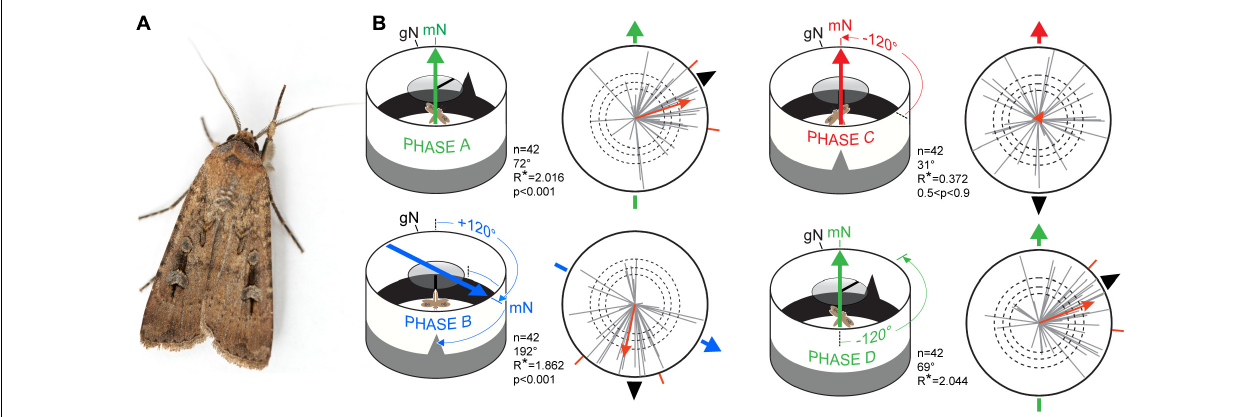
FIGURE 6 | Migratory orientation in Bogong moths is multimodal. (A) A male Bogong moth ( Agrotis infusa ). (B) Experimental procedure and results. Each tethered moth was subjected to magnetic and visual cues during four 5-min phases (termed phases A–D) and their directions and directedness (orientation and length, respectively, of gray vectors in circular plots) measured. When the positions of the magnetic field ( heavy colored arrows ) and visual landmarks ( black triangular ‘mountain’ and overhead stripe ) are correlated and turned together (Phases A,B,D), the moths ( n = 42, gray vectors ) remain significantly oriented near the landmarks (as indicated by the long (highly directed) red population mean vectors ; p < 0.001). When the two cues are set in conflict (Phase C), moths become disoriented (as indicated by the short (undirected) red population mean vector ; 0.5 < p < 0.9). The directedness (length) of the population mean vector is given by its R* value: the greater the R* value, the more directed the population of moths it represents. The R* value also reveals the likelihood that the mean flight direction of a population of moths – where each moth has its own direction and directedness (direction and length of gray vectors ) – differs significantly from a random, undirected population (according to the Moore’s modified Rayleigh test: Moore, 1980). Dashed circles : required α -level for statistical significance (i.e., the R * value required to reliably distinguish the directedness of the population from a random, undirected population): p < 0.05, p < 0.01, and p < 0.001, respectively, for increasing radius. Outer radius of plots: R* = 2.5. Red radial dashes : 95% confidence interval. gN, geographic North. mN, magnetic North. Data are from Dreyer et al., 2018b and diagram from Johnsen et al., 2020. The photo of the Bogong moth in A is courtesy of Dr. Ajay Narendra, Macquarie University,